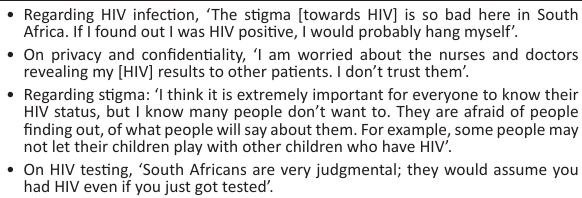
FIGURE 1: A graphical representation of key patient attitudes towards emergency departments-based HIV testing on a Likert scale. BOX 1: Patient quotes collected during